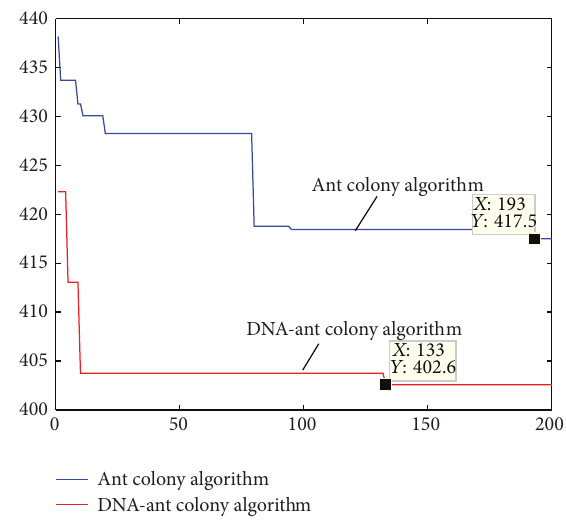
Figure 10: Distribution cost optimization curve (moderate or high level